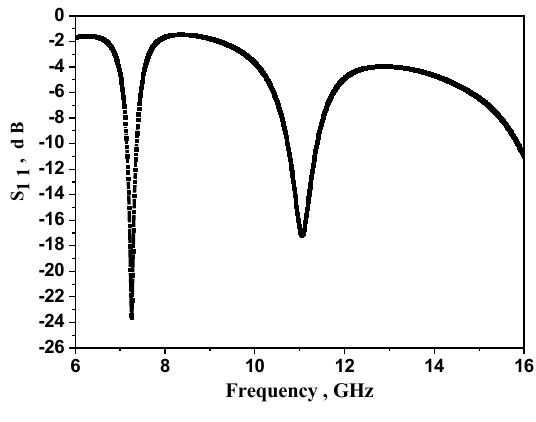
Fig.7. The simulated S 11 of the proposed antenna.